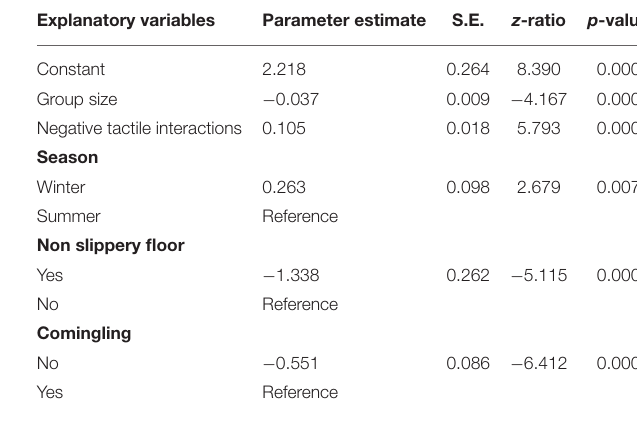
TABLE 5 | Parameter estimate, standard error ( SE ), and significance for the models of average behavioral events index during unloading, penning, and loading of cull cows in the